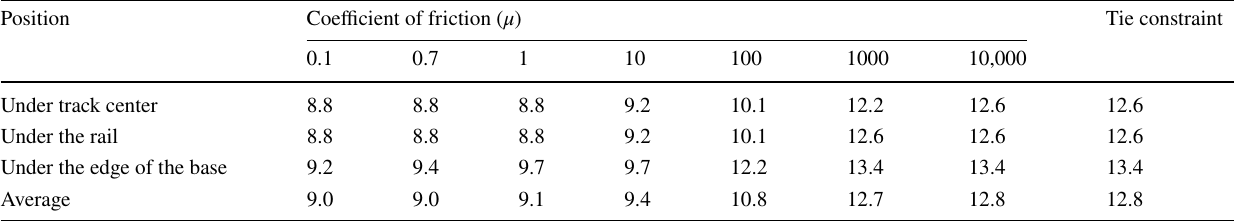
Table 2 The numerical results of longitudinal influencing length of stress on roadbed (unit: m) Position Coefficient of friction ( μ ) Tie constraint